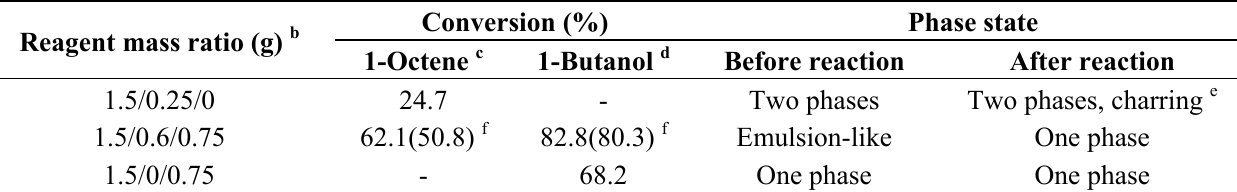
Table 1. Phase state and conversions (%) of 1-octene and 1-butanol over silica sulfuric acid (SSA) at 120 °C for 3 h a .